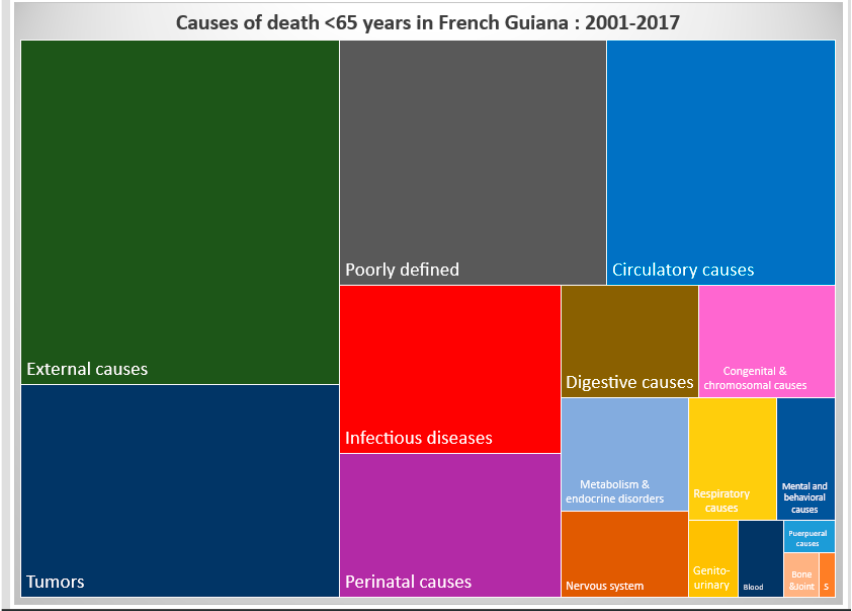
Figure 3. Treemap of the causes of premature deaths in French